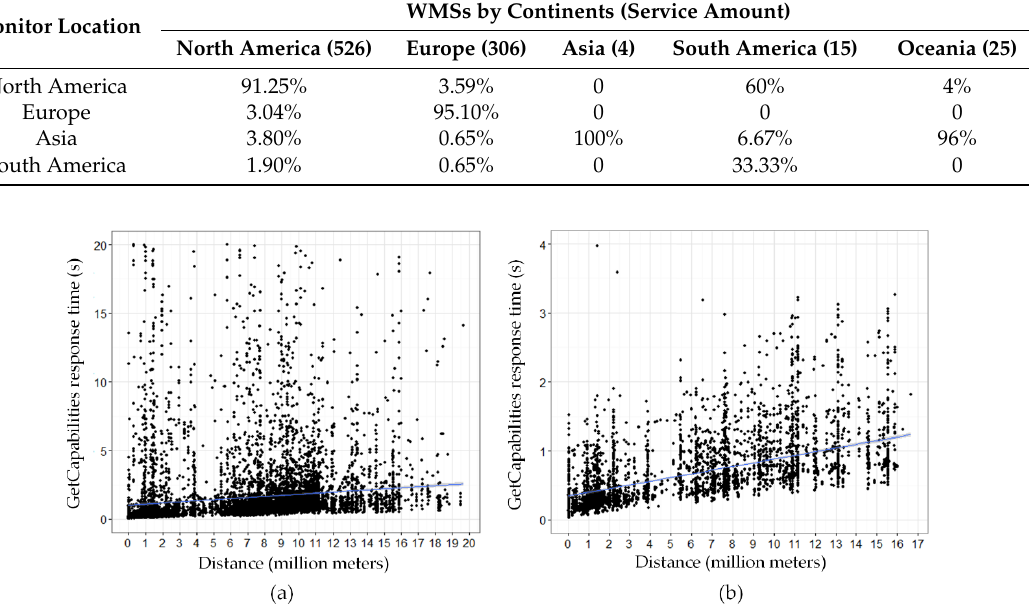
Figure 14. Correlation between response times and spatial distance from monitoring sites to WMS servers. ( a ) The 876 valid WMSs and ( b ) the selected 393 WMSs located in the U.S. whose capabilities documents were less than 1 MB with average response times less than two seconds.